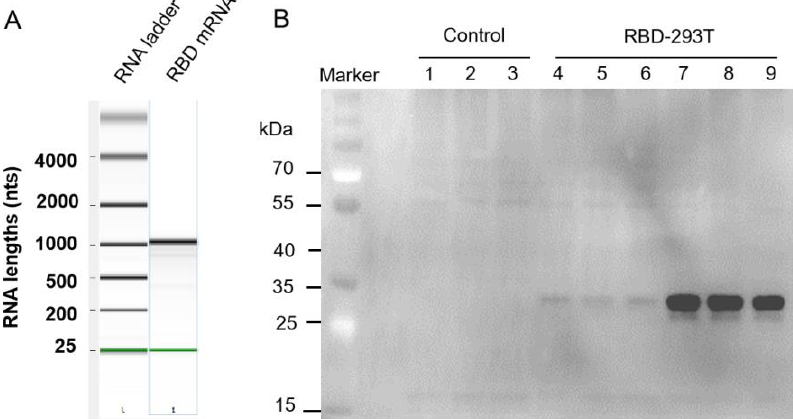
Figure 3. Characterization of SARS-CoV-2 receptor-binding domain (RBD) mRNA. ( A ) Gel-like image of in vitro synthesized RBD mRNA interrogated using an RNA chip on an Agilent Bioanalyzer. Data for RNA markers, RBD mRNA, are presented from left to right. ( B ) Western blot for SARS-CoV-2 RBD protein expression in 293T cells when the RBD mRNA was transfected into 293T cells with an additional 24 h of treatment along with 1 µ g and 3 µ g of RBD mRNA. Lanes 1–3: control; Lanes 4–6: 1 µ g of RBD-293T; Lanes 7–9: 3 µ g of RBD-293T.